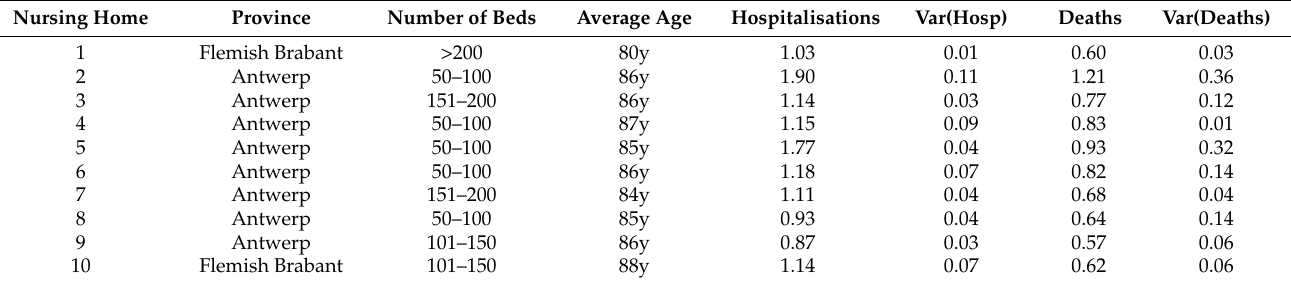
Table 1. The variance of hospitalisation and number of deaths is represented in Table 1 as well. Table 1. Description of the 10 participating nursing homes including the average number of daily hospital admissions and deaths calculated per 1000 residents per nursing home, across five years of reference period. Variance (Var), hospitalisa- tion (hosp).